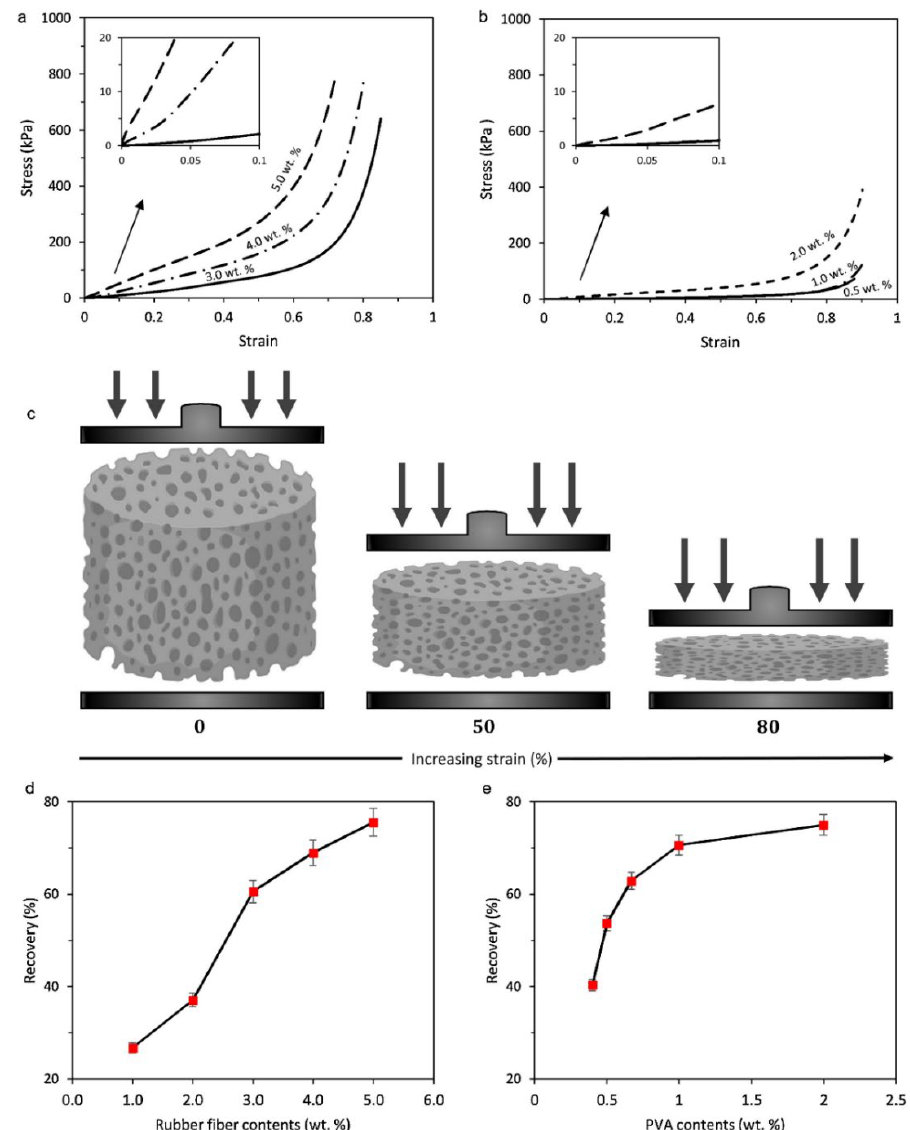
Figure 17. ( a ) Compressive stress–strain curves of rubber aerogels with various contents of WTTF and constant PVA content (1 wt.%). ( b ) Compressive stress–strain curves of rubber aerogels at various PVA contents and constant WTTF content (2 wt.%). ( c ) Schematic description of the changes in the cellular structure with compressive deformation. ( d , e ) Recovery performance of rubber aerogels after compression with varying contents of WTTF and PVA [105].